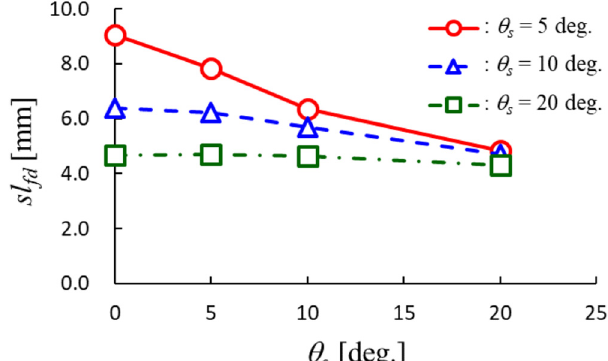
Fig. 12. In fl uence of u s and u c on sl fd .